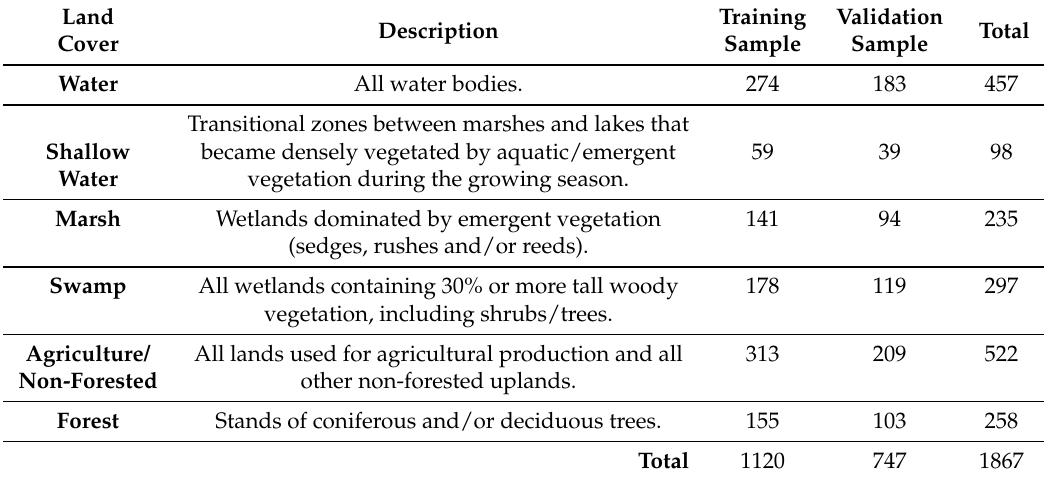
Table 1. Description of the land cover classes identified throughout the study